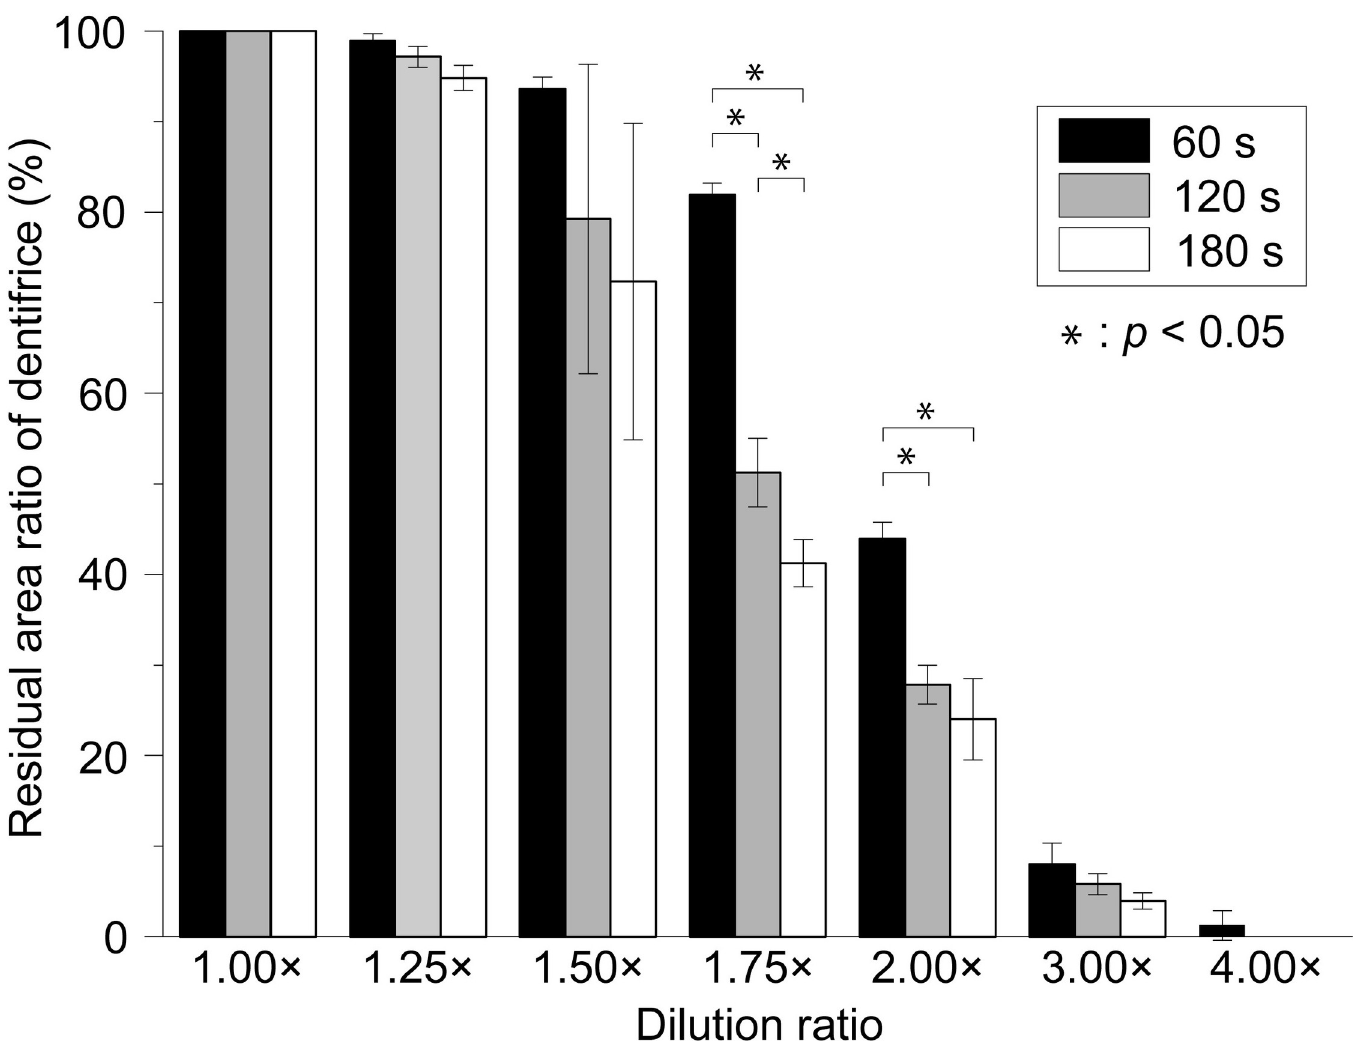
Fig 3. Dentifrice residual area ratio every 60 s at each dilution ratio. Fig 3 shows the residual area ratio of the dentifrice (%) at 60, 120, and 180 s for each dilution ratio. Data for each group are presented as the mean ± standard deviation (SD) of three replicates (n = 3). Statistical analysis among the test groups is performed using the analysis of variance (ANOVA) and the Bonferroni test (p <